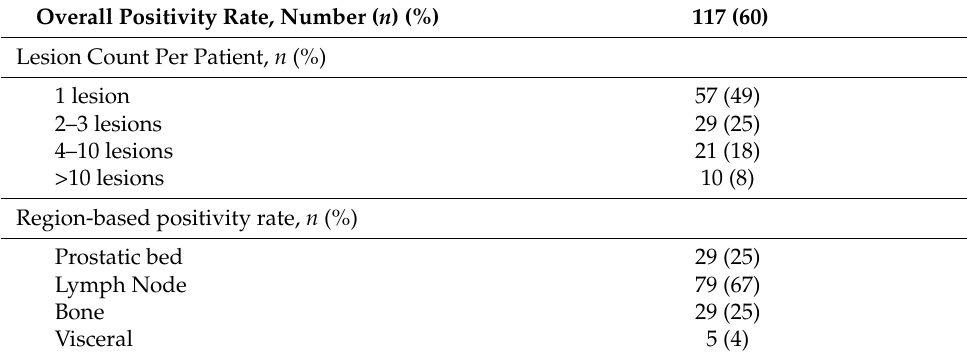
Table 2. Positivity rate of 68 Ga-PSMA-11